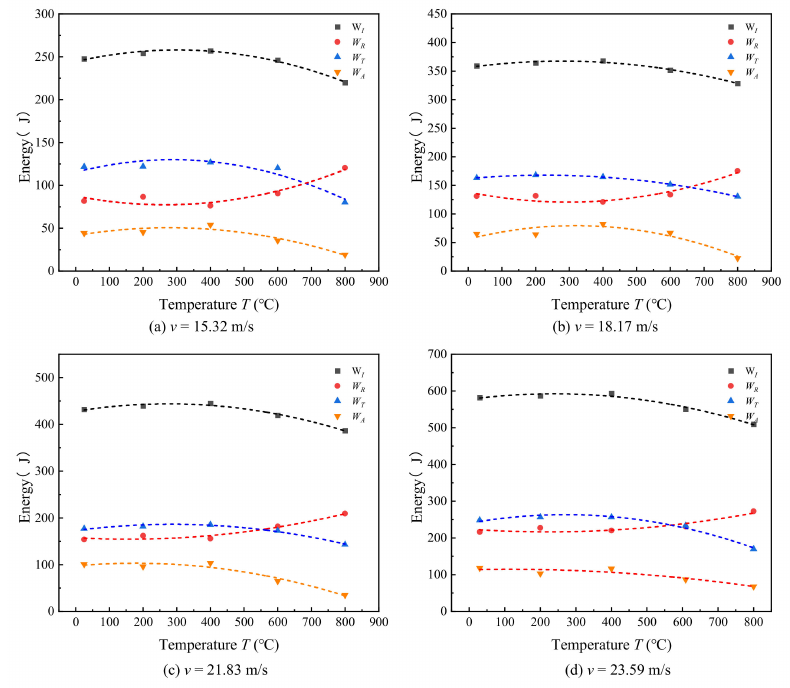
Figure 12. Change of energy with temperature under different impact velocity.